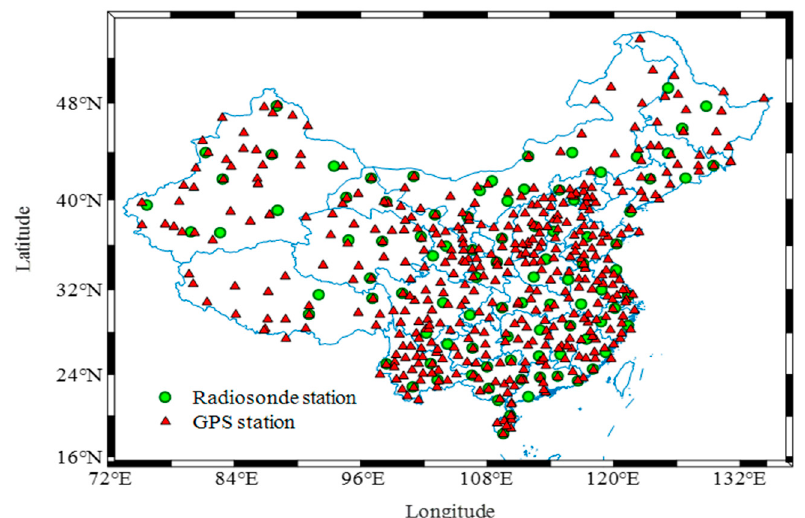
Figure 1. Distribution of GPS stations from the infrastructure construction of national geodetic datum modernization and Crustal Movement Observation Network of China (CMONC) in mainland China. The green circle is the radiosonde station, and the red triangle is the GPS station.